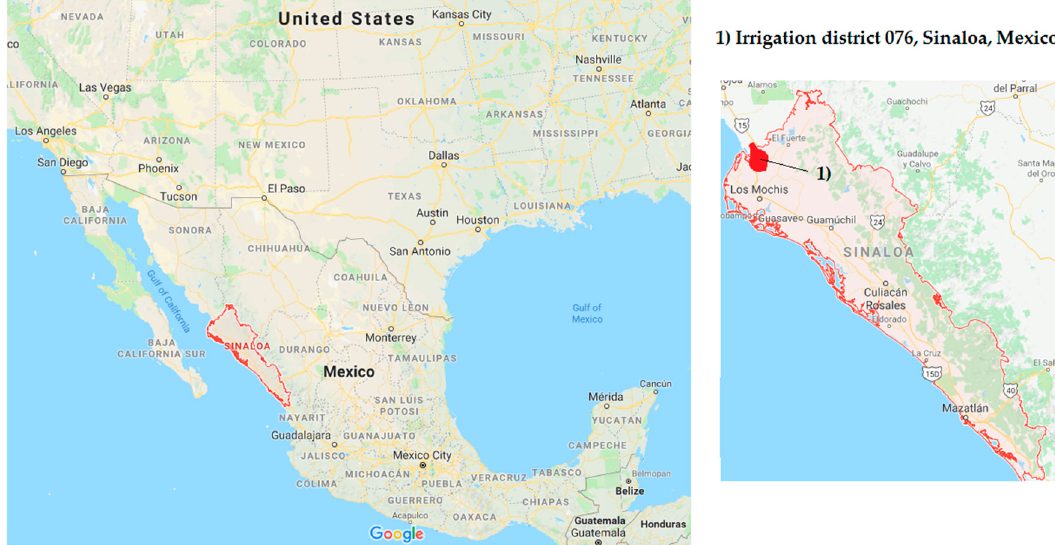
Figure 1. Location of the study area: Irrigation District DR076, Sinaloa Mexico [24].